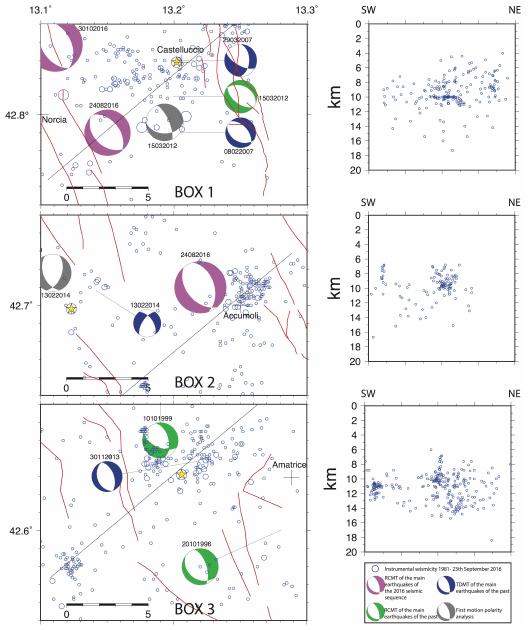
Figure 5. Epicentral map, hypocentral distribution (cross section) and focal mechanisms of the: BOX 1, 2007 Castel- luccio seismic sequence, yellow star: February 2007 Mw 3.9 earthquake; BOX2, 2014 Accumoli seismic sequence , y ellow star: February 2014 Ml 3.5 earthquake; BOX3, 2013 Amatrice seismic sequence, yellow star: November 2013 Mw 3.7